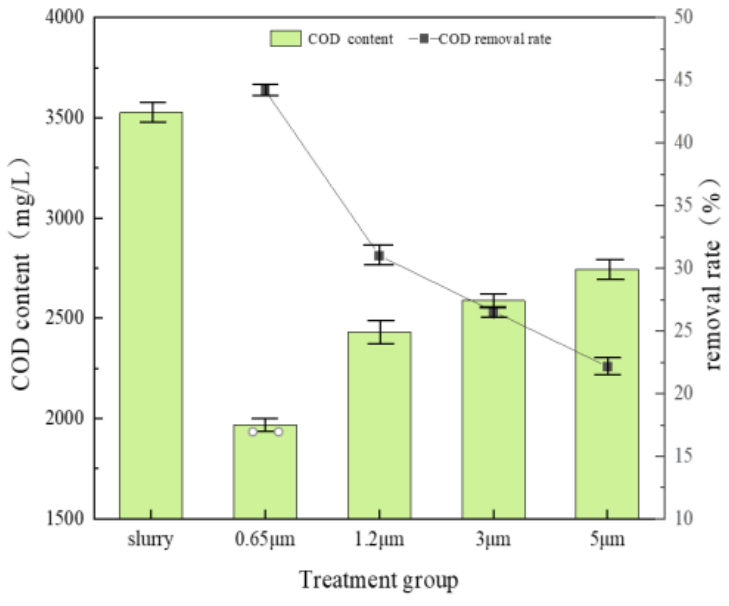
Figure 2. Effects of the microfilter membrane system on COD.